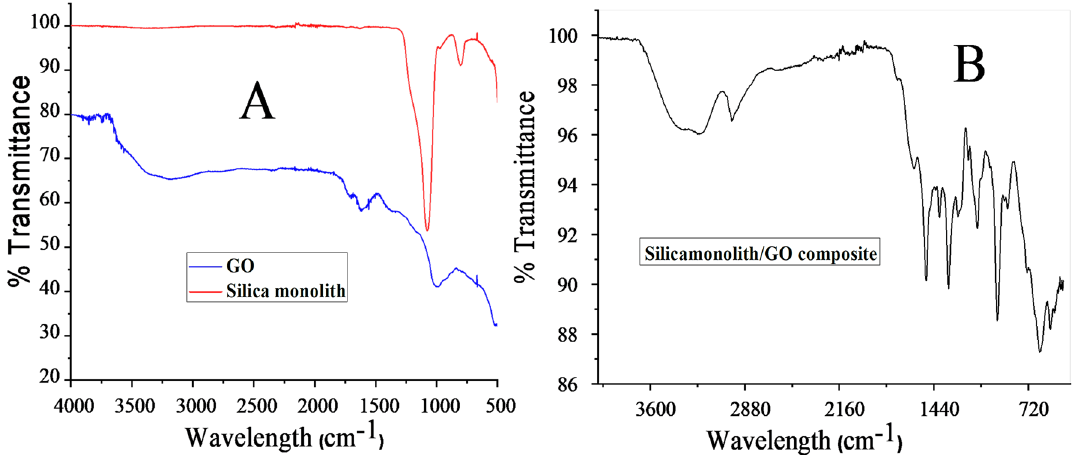
Figure 2. FTIR images of graphene oxide and silica monolith ( A ): silica bound graphene oxide composite ( B